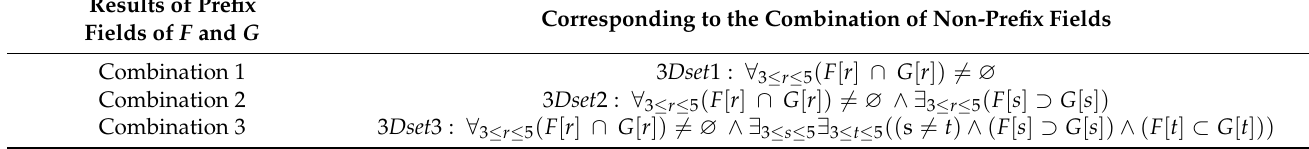
Table 3. All combinations for 5D filter conflict. Corresponding to the Combination of Non-Prefix